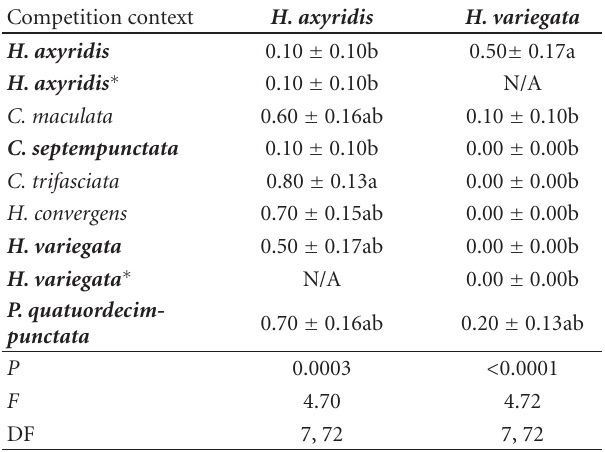
Table 3: Number of aggression events (mean ± SE) delivered by H. axyridis and H. variegata in di ff erent competition contexts (see text for details). Means in each column followed by the same letter are not significantly di ff erent from each other (Tukey’s HSD tests, P < 0 . 05). Nonnative species are printed in bold